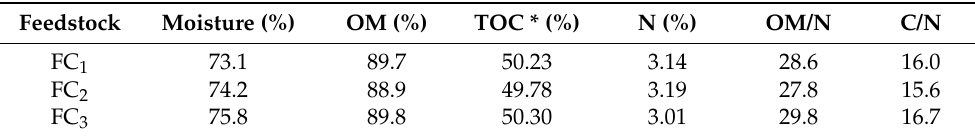
Table 3. Feedstocks